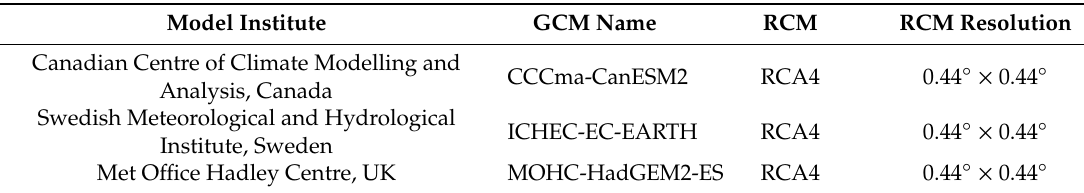
Table 1. List of Global Climate Models (GCMs) and Regional Climate Model (RCMs) employed.